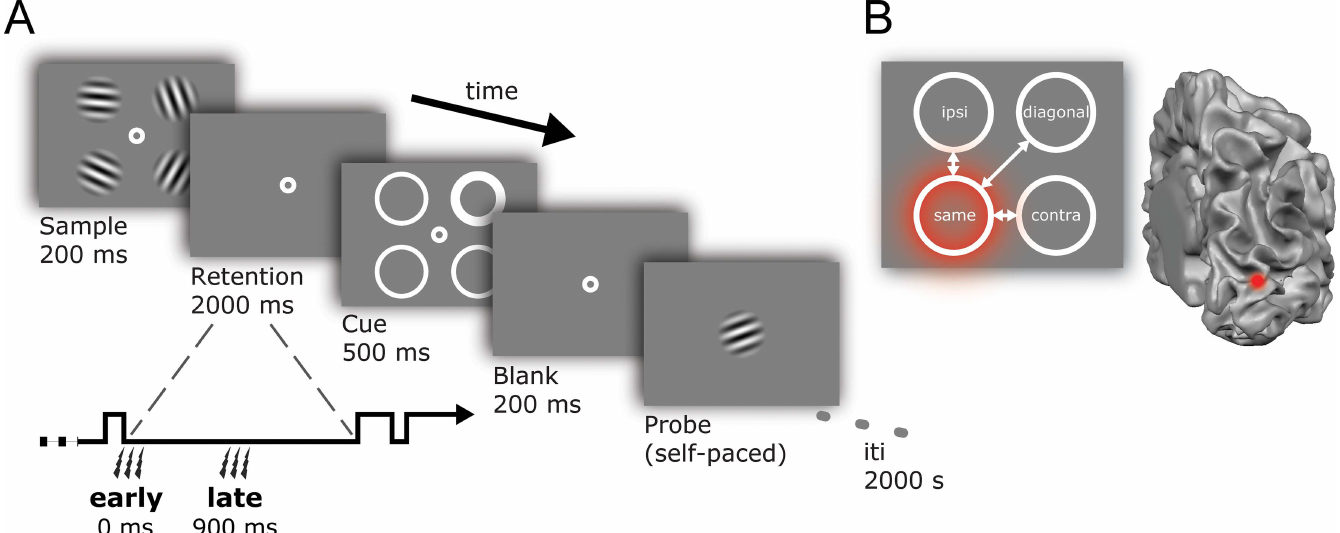
Fig 1. Trial sequence and relative locations. (A) Participants vieweda sample array with 4 randomlychosen orientations, and remembered these over a two-seconddelay. During the delay participants received3 pulses of real or sham TMS over their left or right hemisphere. The pulses happenedeither directly at the offset of the sample array, or midwayduring the delay. A cue array indicatedwhich of the four orientations was probedfor recall, and after a short blank, participantsrotated a test grating via button presses to match the cued orientation. (B) Responses at the four visual field locationswere analyzedaccordingto their position relative to the pulse. The visual field positiontargeted by the pulse could overlap with the memory item that was cued (‘same’), the cued item could be contralateral to the affected visual field location (‘contra’), it could be ipsilateralto it (‘ipsi’), or diagonalto it (‘diagonal’). In the exampledepictedhere, right early visual cortex is stimulated, targeting the lower-left visual field. Consequently, the upper left position becomes‘ipsi’, the upper right position‘diagonal’,the lower left ‘same’, and the lower right position‘contra’–relative to the visual field locationaffected by the TMS pulse.